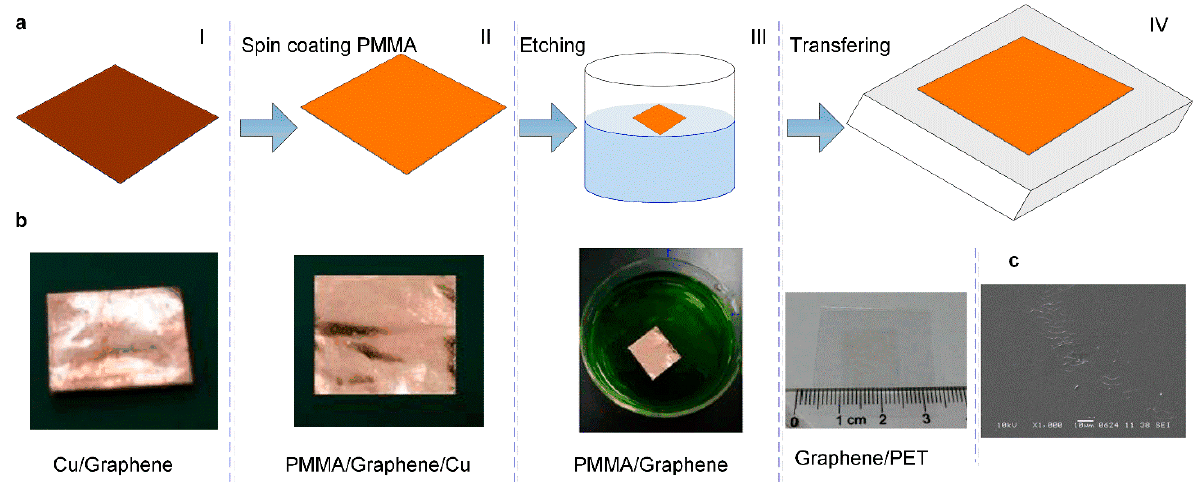
Figure 2. The preparation processes of graphene film. ( a ) The schematic of the fabrication processes of graphene film. ( b ) The physical preparation processes of the graphene film. ( c ) The plane view SEM image of the prepared graphene film.